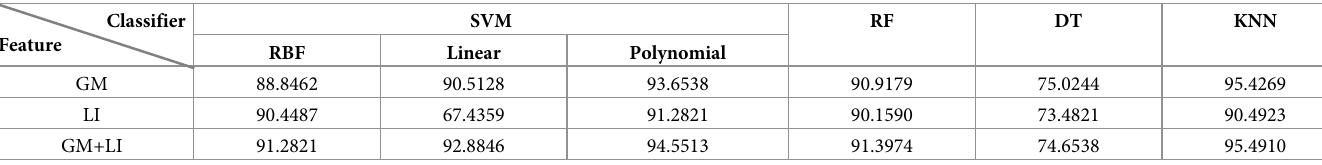
Table 1. Classification results in NC versus EMCI under three kinds of features(%). Classifier